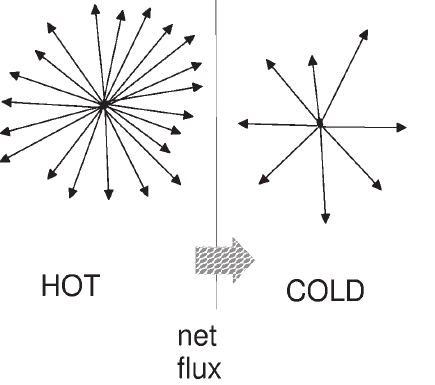
Fig. 2. Cartoon representing electron scattering at one point from a hot region and one point from a cold region. The collision frequencies are assumed to be larger in the hot region. A net flux of particles is produced at the interface owing to the di(cid:128)erence in collision frequencies